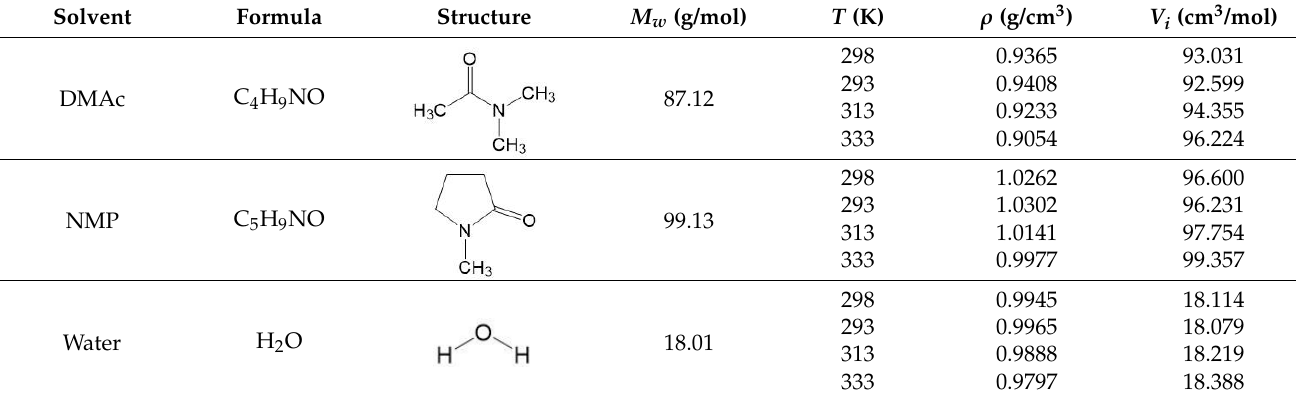
Table 1. Chemical structure and relevant properties of solvents and non-solvents. Data at 298 K are reference (ref) values. Solvent Formula